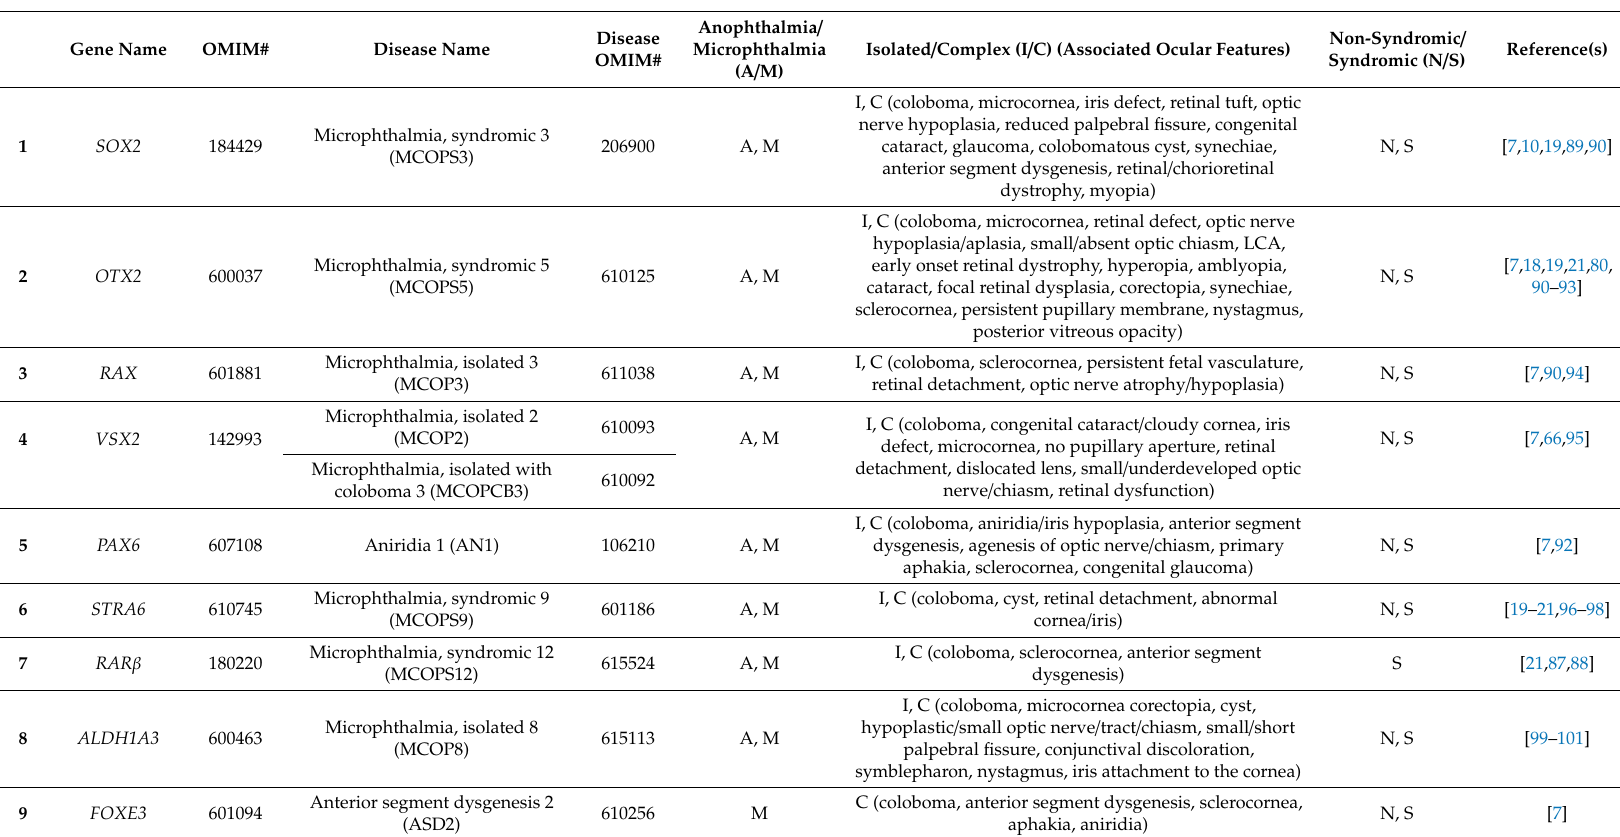
Table 1. Genes associated with anophthalmia and microphthalmia. A—unilateral or bilateral anophthalmia. M—unilateral or bilateral microphthalmia. I—Isolated AM with no additional ocular features. C—complex AM (additional ocular features found in microphthalmic or contralateral eye of the patient listed). N—no syndromic features observed. S—systemic features